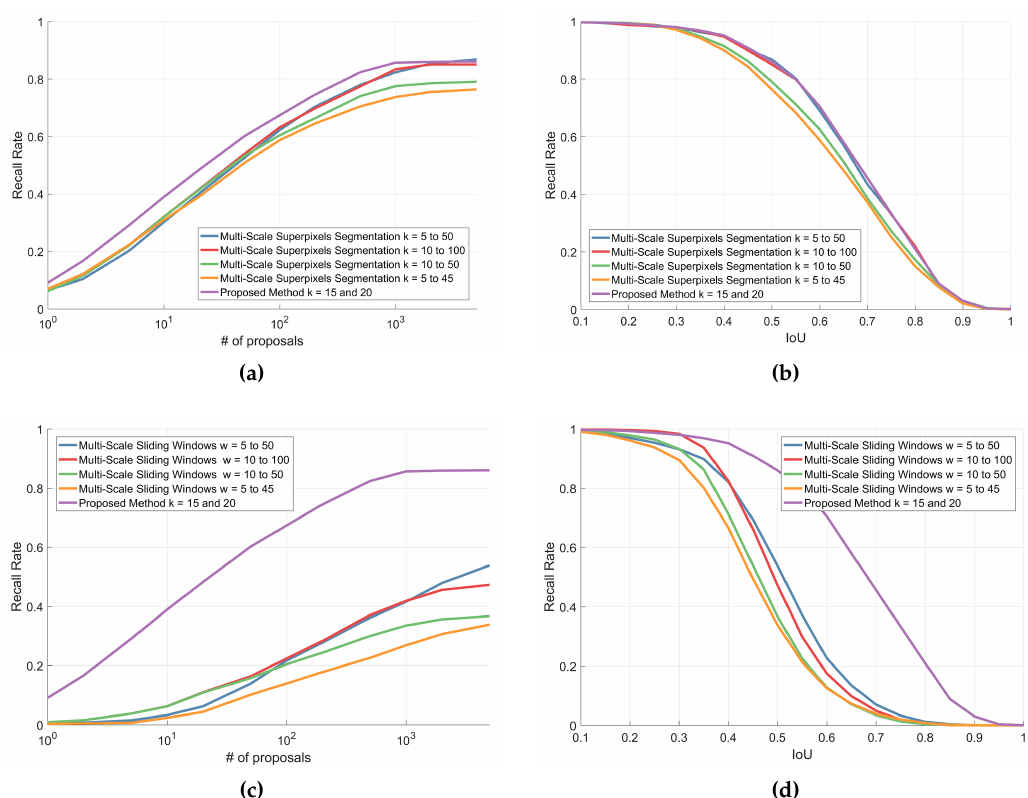
Figure 6. The recall using the proposed method, multi-scale superpixels segmentation and multi-scale sliding windows. Comparison of the proposed method to multi-scale superpixels segmentation: ( a ) the curves measuring the recall versus numbers of ship proposals; ( b ) the curves measuring the recall versus IoU. Comparison of hierarchical superpixels grouping to multi-scale sliding windows: ( c ) the curves measuring the recall versus numbers of ship proposals; ( d ) the curves measuring the recall versus